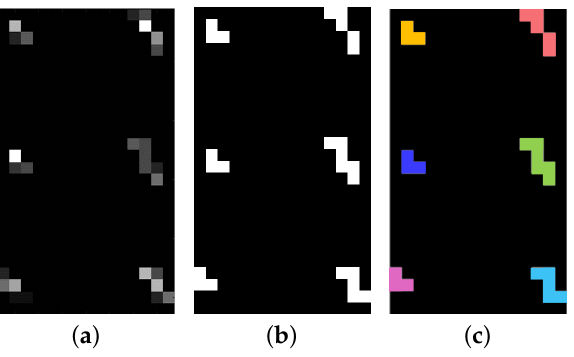
Figure 9. The clustering process of the power line points. ( a ) The gray image formed by the projection of spatial line clusters. ( b ) The binary image after thresholding. ( c ) Labeling of clusters of conductors.